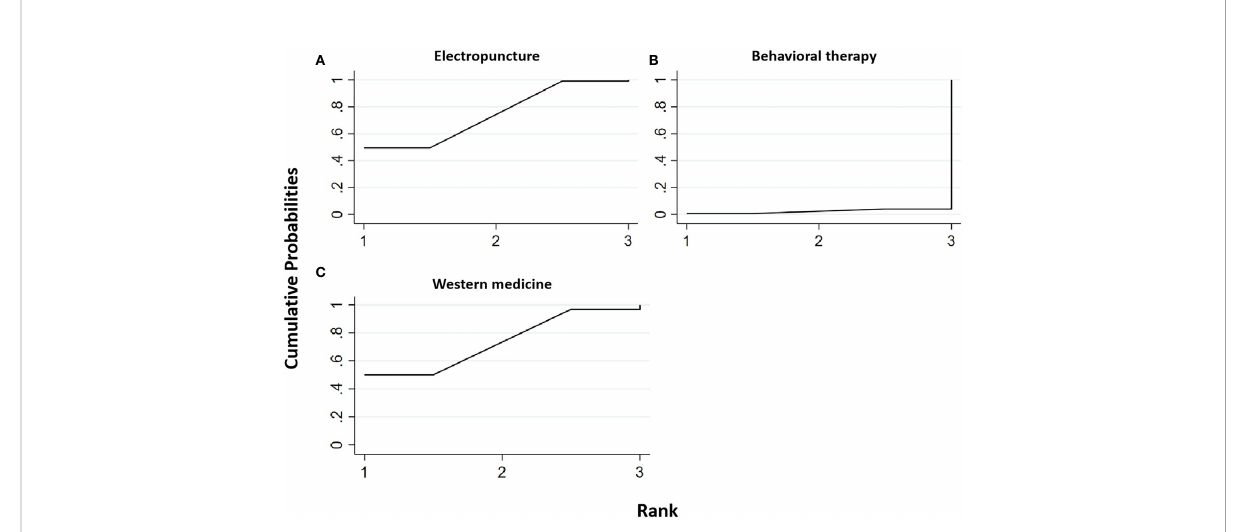
FIGURE 10 Ef fi cacy ranking and cumulative probability graph of total cholesterol (TC) treated by different types of intervention. Comparison of ef fi cacy ranking and cumulative probability of TC between each kind of intervention. (A) Electropuncture, (B) behavioral therapy, and (C) western medicine.